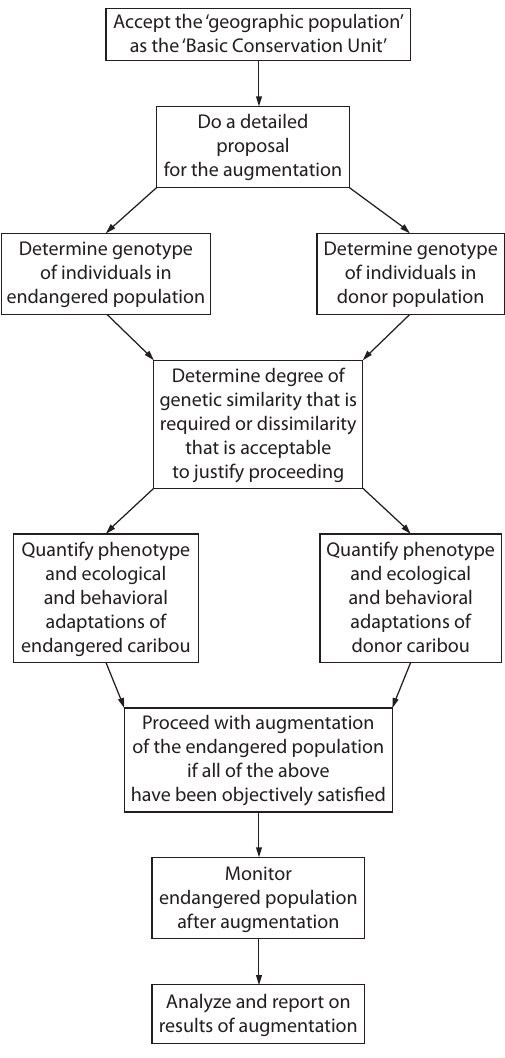
Fig. 1. Protocol for augmentation of an endangered cari- bou population with caribou from a viable wild